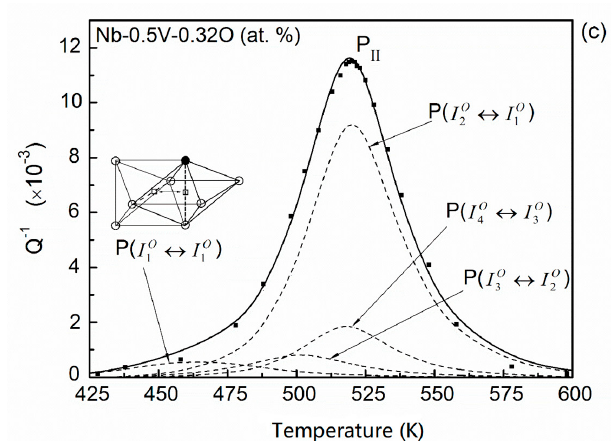
Figure 7. Temperature dependence of the relaxation peak and the fitting results for ( a ) Nb–0.5V–0.07O, ( b ) Nb–0.5V–0.18O, and ( c ) Nb–0.5V–0.32O (at. %) alloys (points—experimental; dashed line—fitted elementary peaks; solid line—the sum of the elementary peak). ( ○ —Nb atoms, ● —V atoms). (cid:35)